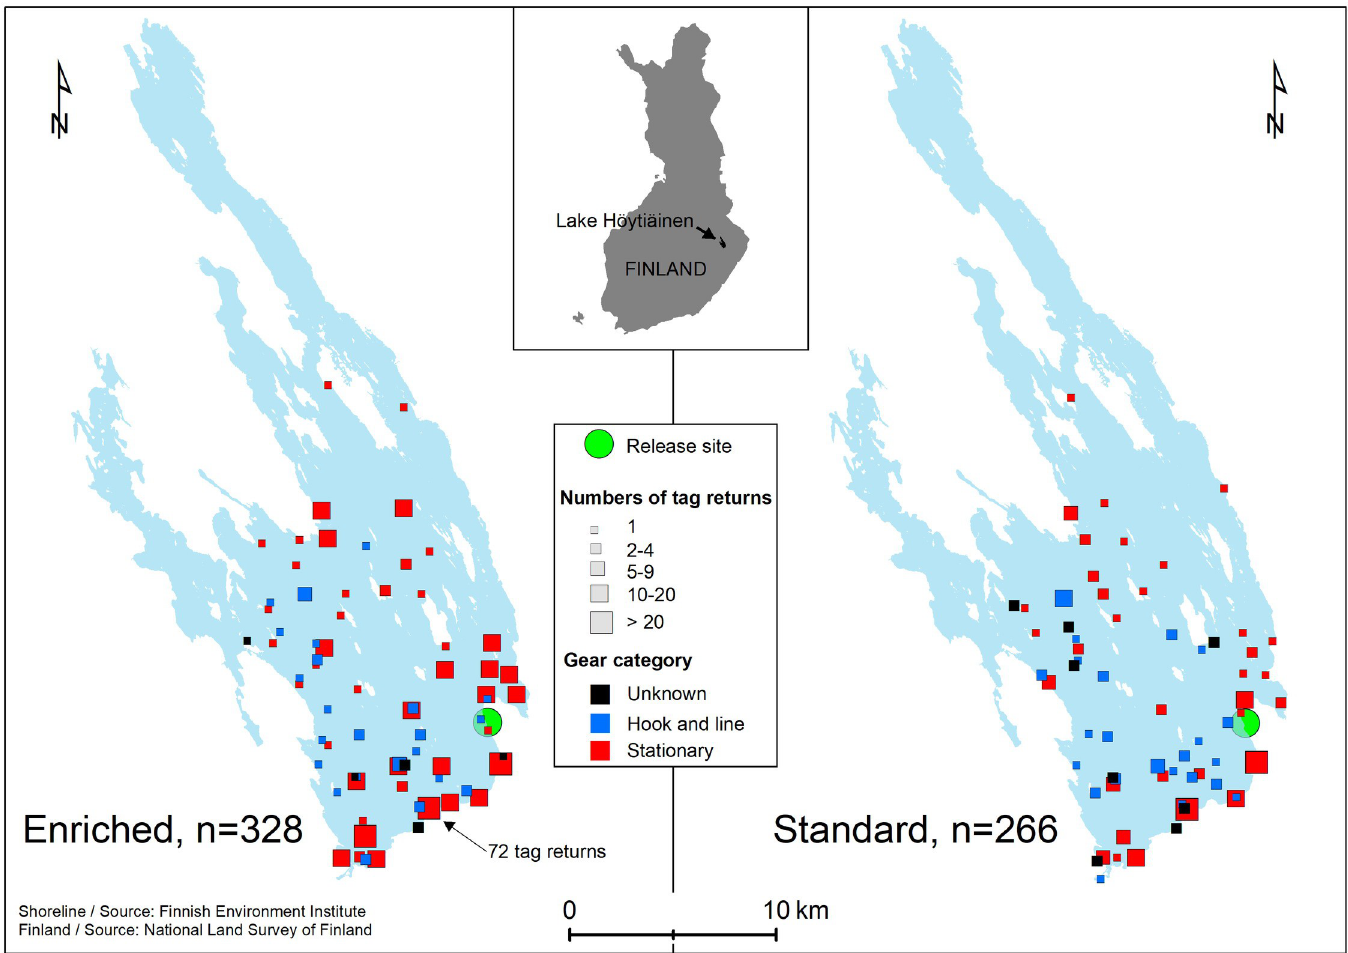
Fig 6. Map graphs of Lake Ho¨ytia¨inen showing the spatial distribution of tag returns for the released 3-yo salmon in regard to rearing method and gear category. The largest number of returns for one location is indicated on the left-sided graph. The graphs were reprinted using two open information sources from the Finnish Environment Institute (lake shoreline) and National Land Survey of Finland (map of Finland) [44, 45]. Spatial distributions of captures for enriched- and standard-reared 3-yo salmon in Lake Ho¨ytia¨inen.